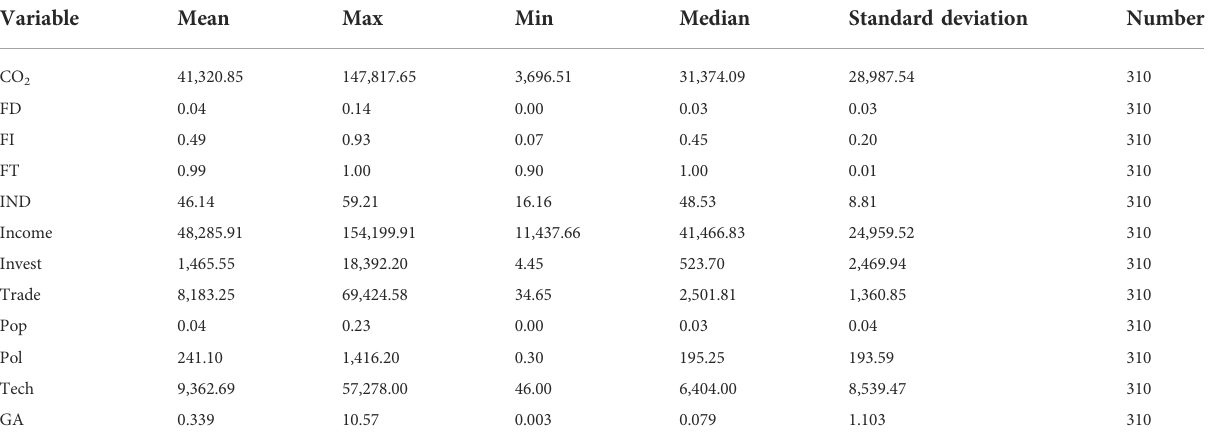
TABLE 2 31 Chinese provinces ’ panel data descriptive